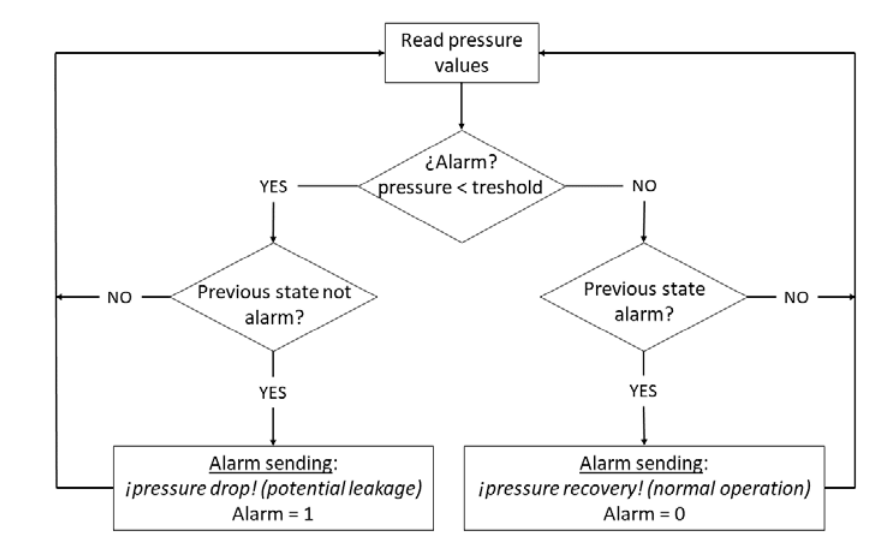
Figure 8. ThingSpeak platform functions in IPSM.